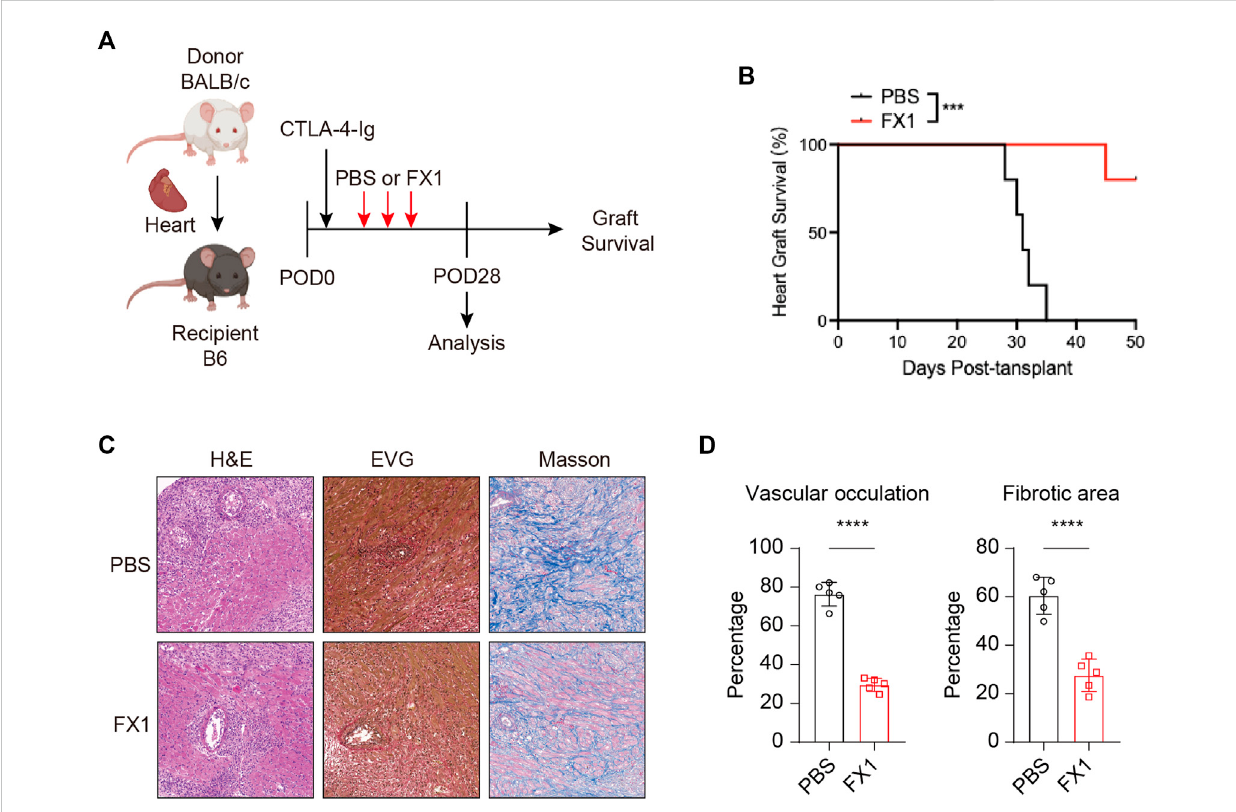
FIGURE 4 FX1 protects chronic cardiac transplant rejection in mice (A) . Illustration of the experimental design in (B – E) . The murine chronic cardiac transplant model was established, and the mice were treated with FX1 or the equivalent amount of PBS three times. The survival time of the cardiac grafts was observed, and the spleens were collected for FCM analysis on the 28th postoperative day (B) . The survival status of the grafts was observed every day through palpation, and thesurvivaltime isillustratedin thesurvival curves ( n = 6) (C) . Graft specimens wereobtained on the28th postoperativeday, and vascular occlusion and fi brosis in the cardiac grafts was assessed by H&E, elastica van Gieson, and Masson staining (D) . The bar charts shows the vascular occlusion and fi brosisof thecardiac grafts( n = 6).Error barsrepresent SD.ns, not signi fi cant, * p < 0.05, ** p < 0.01, *** p < 0.001, **** p <